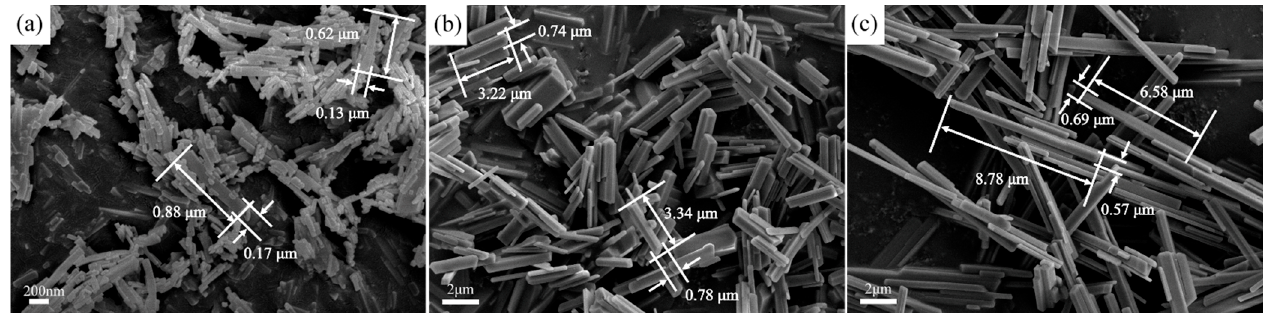
Figure 1. SEM images of NCCO precursor samples: ( a ) NCCO0, ( b ) NCCO1, and ( c ) NCCO2.